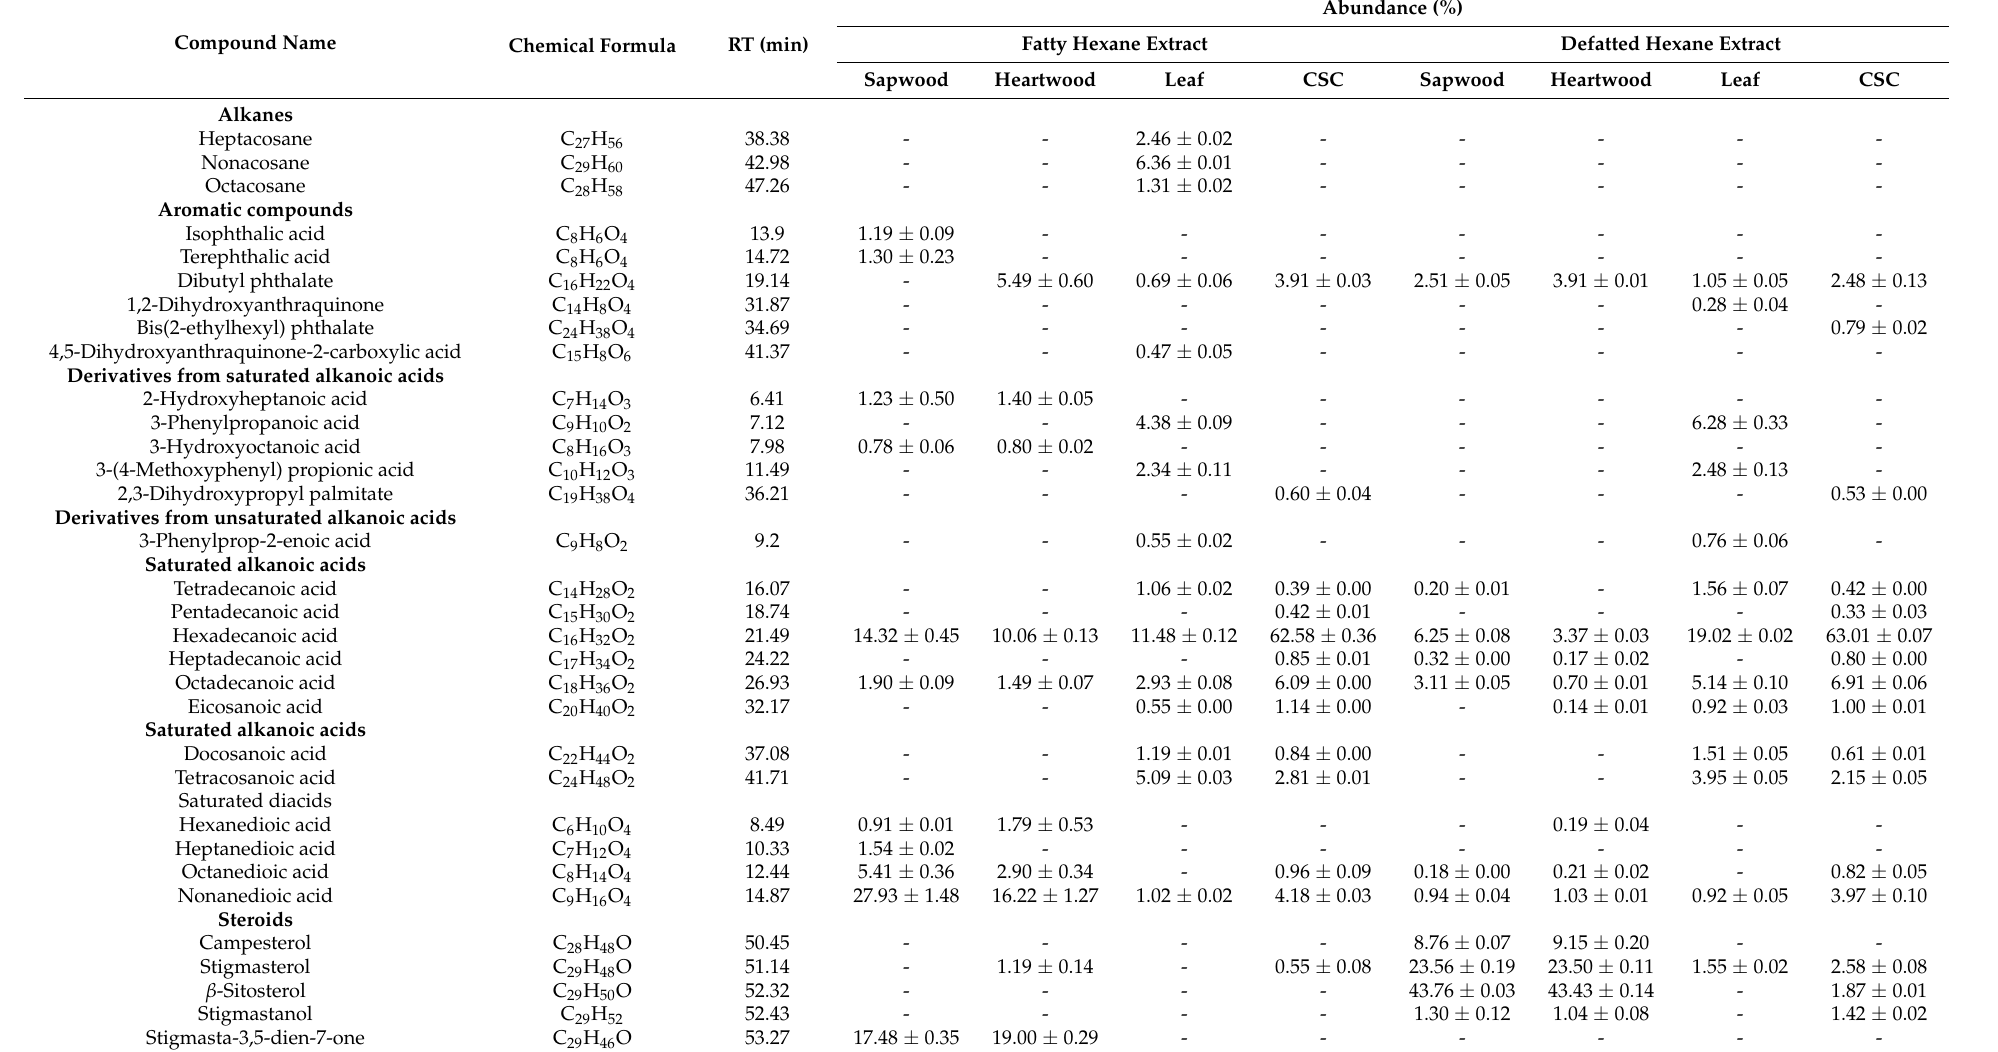
Table 3. Chemical constituents of the hexane extracts of cell suspension culture (CSC) and plant of Eysenhardtia platycarpa identified by